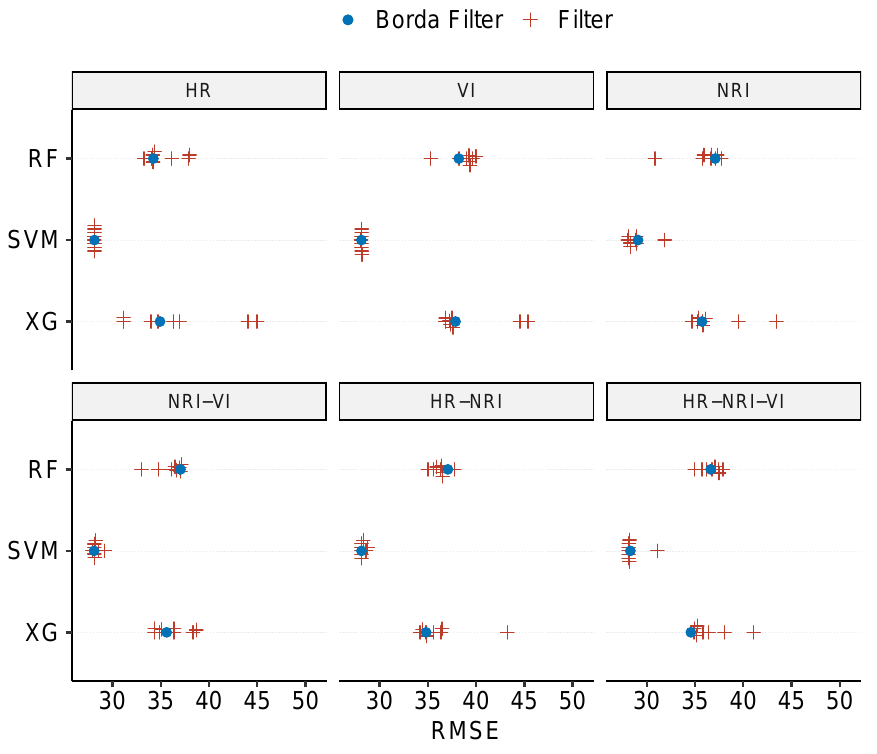
Figure 5. Predictive performances in RMSE (p.p.) when using the Borda filter method (blue dot) compared to any other filter (red cross) for each learner across all